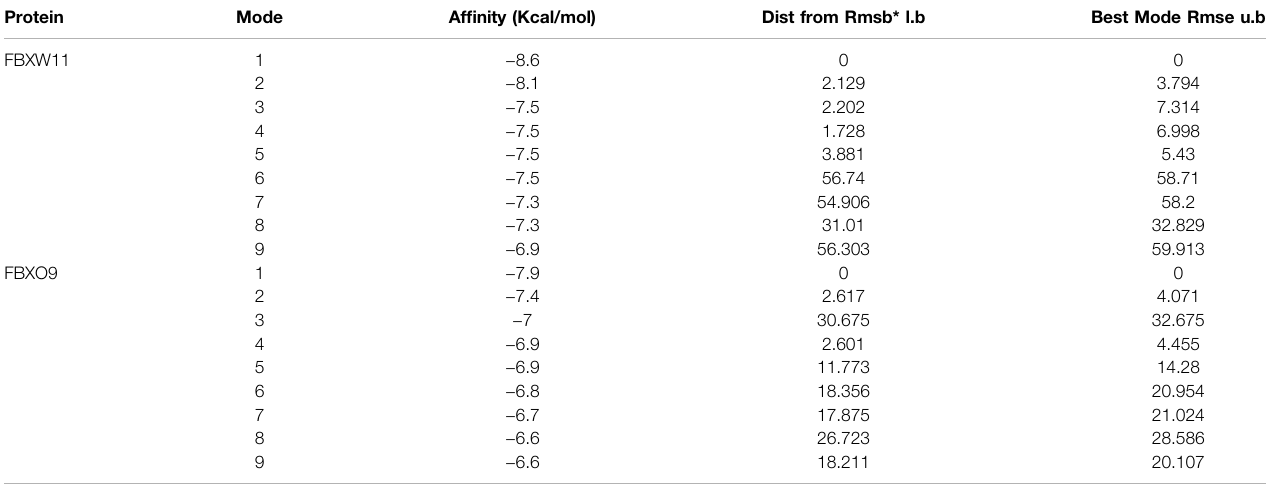
TABLE 1 | MOE scores of FBXW11 and FBXO9 protein with triptolide. Protein Mode Af fi nity (Kcal/mol) Dist from Rmsb* l.b